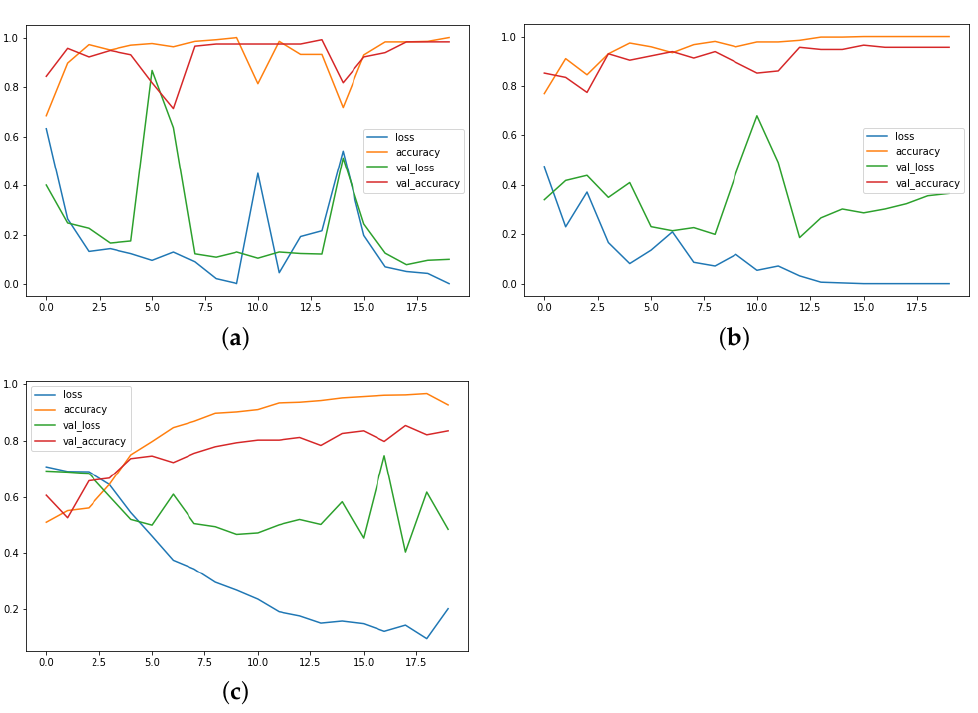
Figure 5. The training and validation accuracies and losses of the proposed model trained using BD-LSTM. The x -axis represents the number of epochs, while the y -axis stands for the unit score of loss and accuracy. (Please zoom in for better reading). ( a ) Peliculas; ( b ) Violence in movies; ( c ) Industrial surveillance